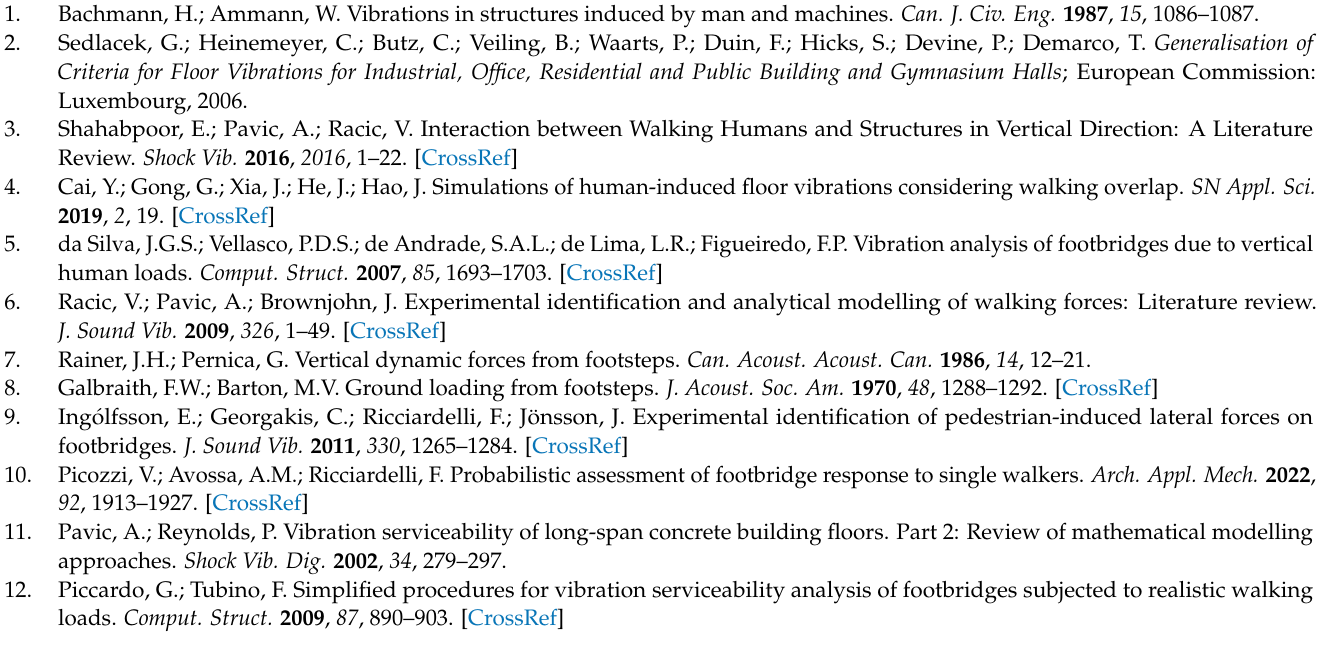
records for SLAB#1, 10 for #2 and 9 for